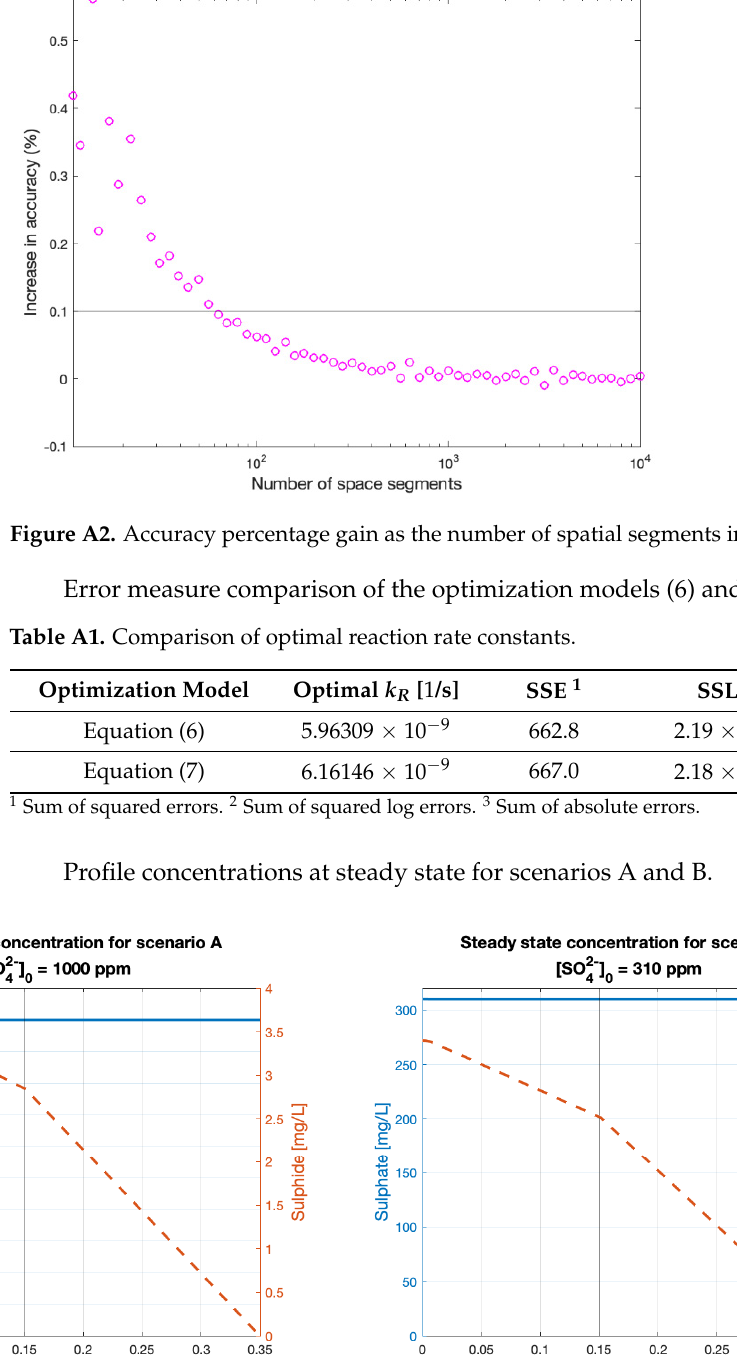
Figure A3. Profile of concentration at steady state for Scenario A, vertical line shows the boundary between the gapfill bentonite and the HCB.